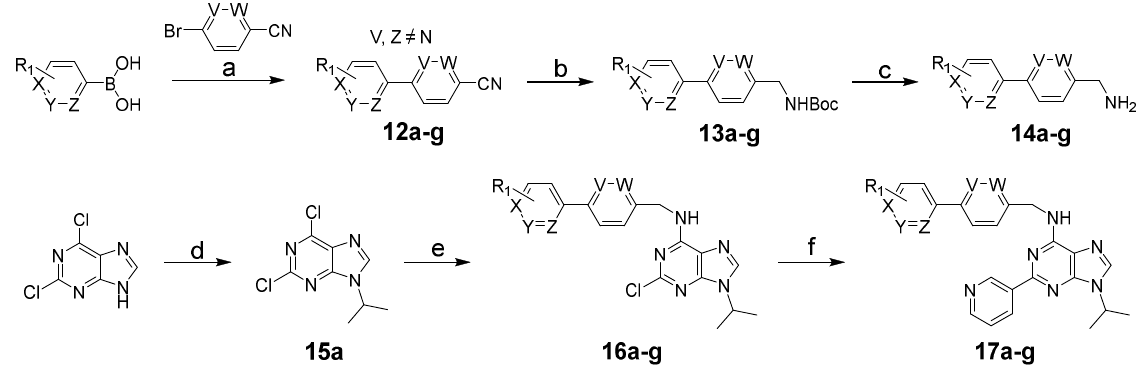
Scheme 1. Synthetic scheme for bipyridyl methaneamines ( 14a–g ) and 17a–g . Reagents and condi-